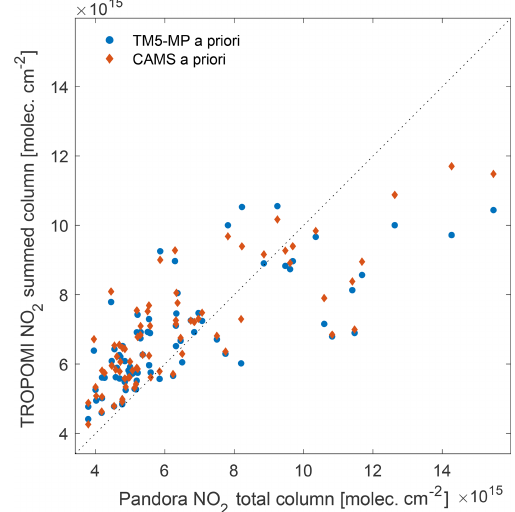
Figure 8. Scatterplot of Pandora and TROPOMI summed columns derived using CAMS regional and TM5-MP a priori NO 2 profiles (blue dots and red diamonds respectively). The comparison includes only those overpasses for which both summed columns were avail- able at the same time during the time interval 30 April to 30 Septem- ber 2018. The 1 : 1 line is plotted as a dotted